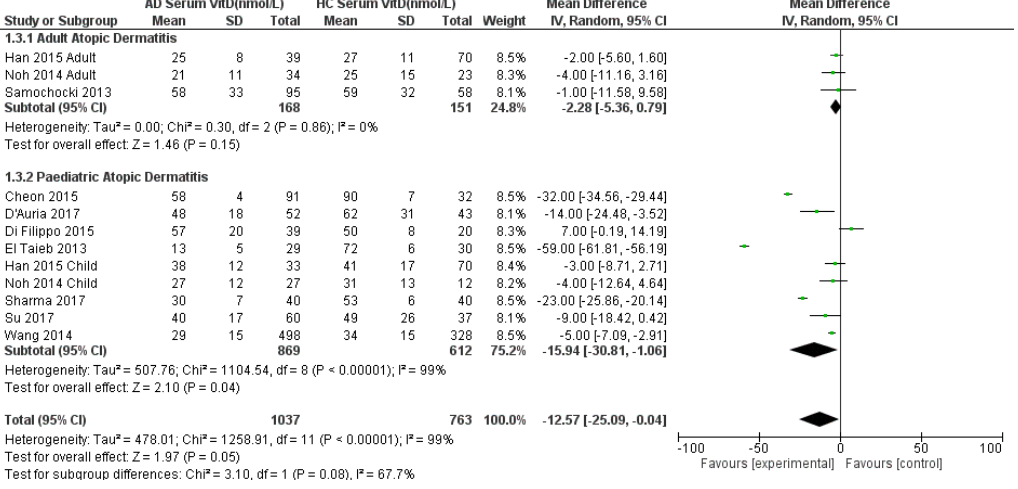
Figure 3. Forest Plot of comparison of serum 25(OH)D levels (nmol/L) in adult and paediatric atopic dermatitis populations versus their age-matched healthy controls, with sub-analysis by age group.